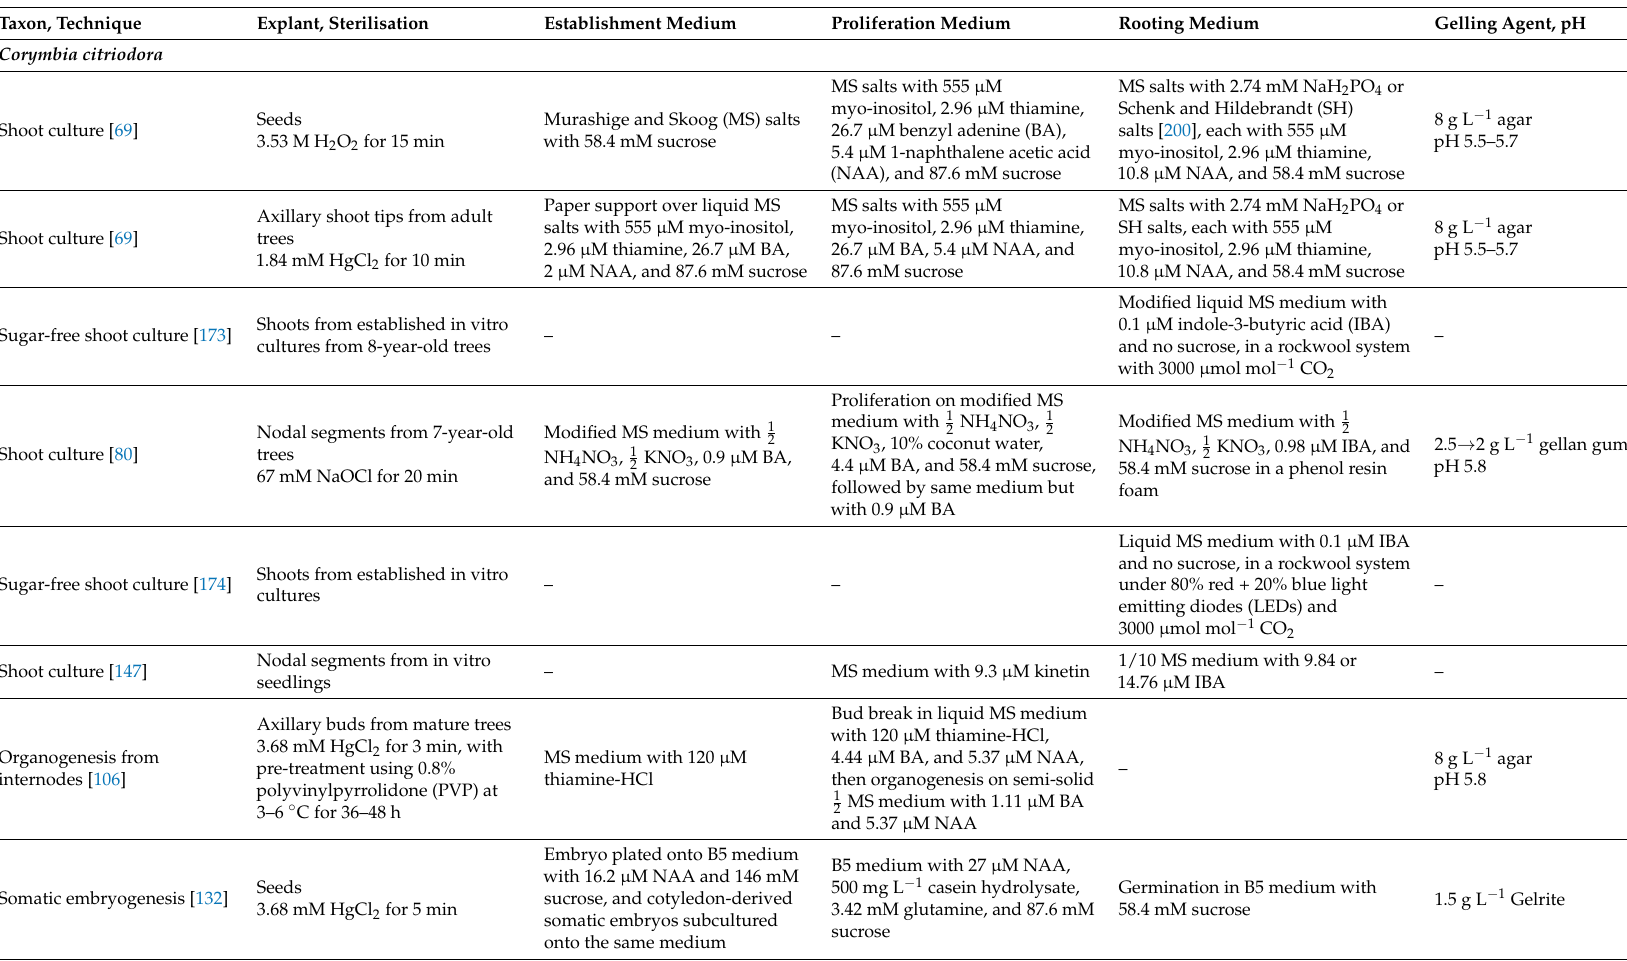
Table A1. Culture techniques, explants, and media used in the micropropagation of eucalypts. Media are aseptic and semi-solid unless stated